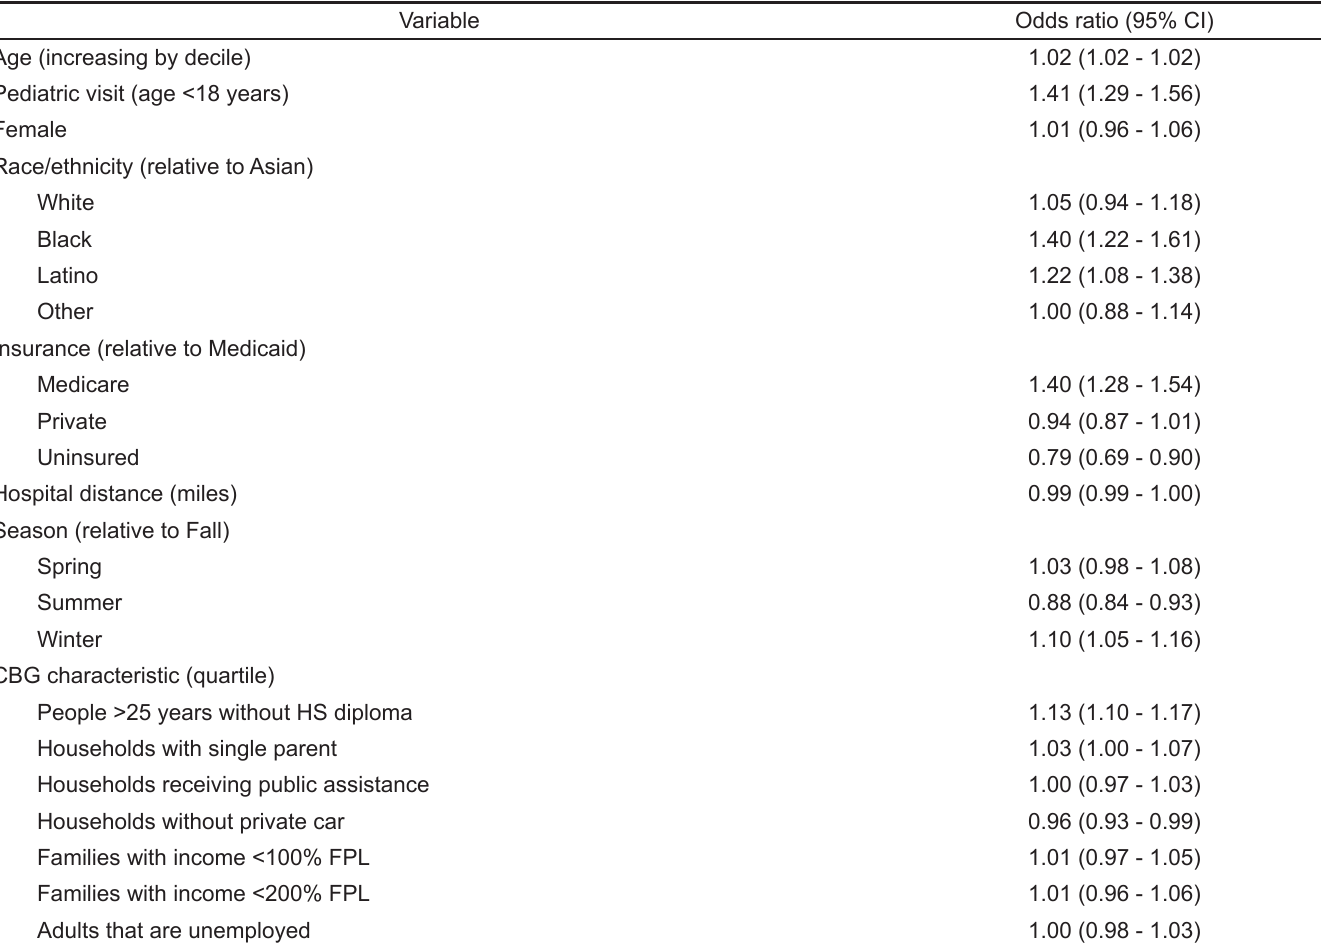
Table 2. Multivariable logistic regression results of the likelihood of an ED visit being categorized as a Prevention Quality Indicator (PQI) vs non-PQI